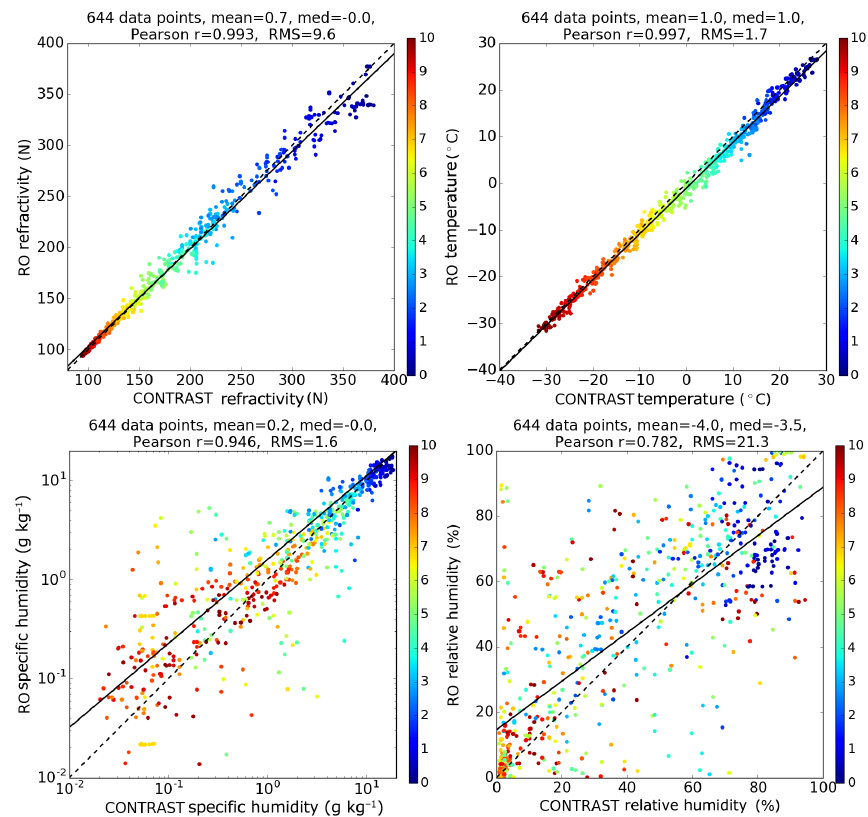
Figure 6. Scatter plots for N (top left), T (top right), q (bottom left, logarithmic scale), and RH (bottom right) for all 3h 600km collocation pairs for RO and CONTRAST. The color indicates the altitude of the